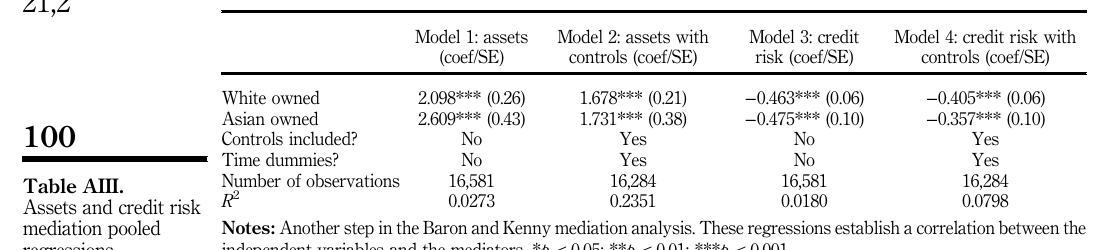
Model 2: Survival – probit (coef/SE)